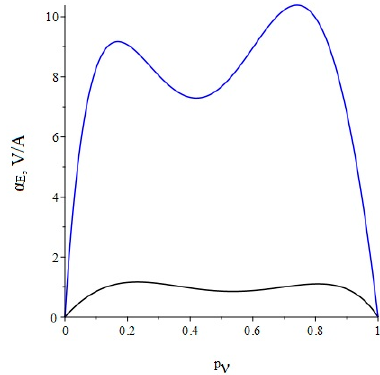
Figure 8. Theoretical dependence of the ME voltage coefficient on the volume fraction of the piezo- electric. Black color of the line is PZT, blue is LN cut y + 128°. electric. Black color of the line is PZT, blue is LN cut y + 128 ◦